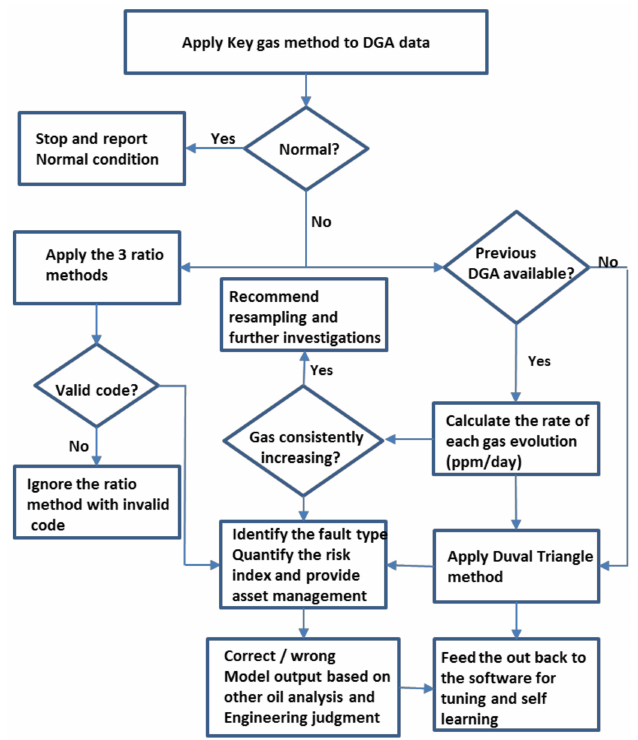
Figure 2. Flow chart of the proposed DGA interpretation